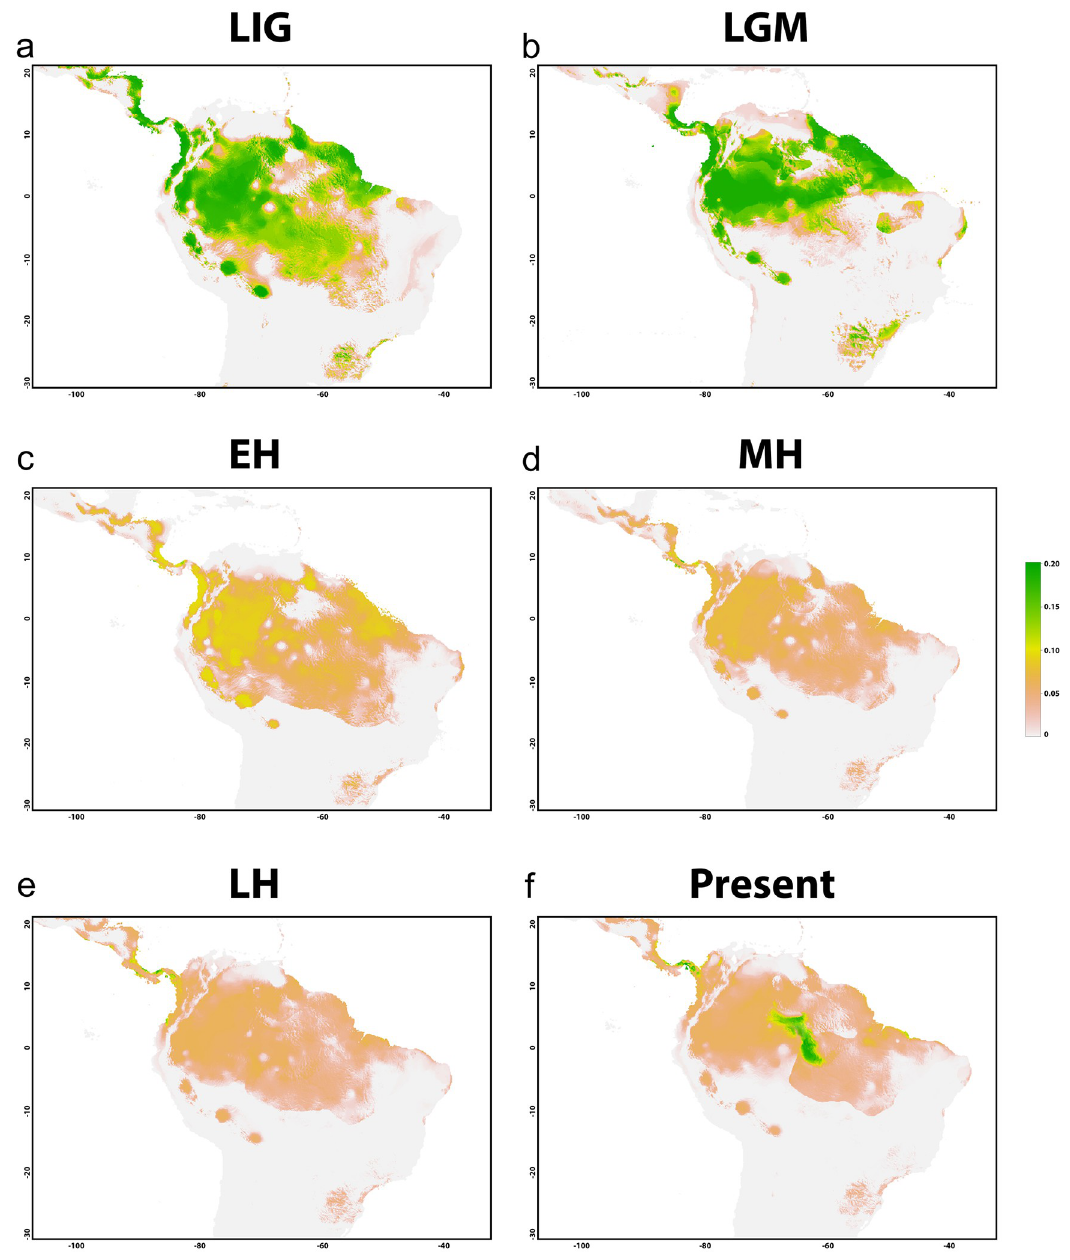
Fig 5. Paleogeographic modelling. Potential climatic niche for P . wallacei recovered in our analyses. (a) Last Interglacial (LIG), (b) Last Glacial Maximum (LGM), (c) Early Holocene (EH), (d) Middle Holocene (MH), (e) Late Holocene (LH) and Present (f). Intense green indicates areas that are more susceptible to the occurrence of the species and yellow tones indicate areas that are less susceptible for P . wallacei . The data were download from PaleoClim (paleoclim.org) and the resulting maps were displayed using the USDM packet in R (R Development Core Team 2017) (https://cran.rproject.org/web/packages/usdm/index.html). pairs and in only one acrocentric chromosome (pattern shared between both cytotypes). In addition, while in the marine species the 18S rDNA was found in centromeric and terminal positions (in some cases in both chromosome arms) [44, 46] in freshwater stingrays the sites are only found on the terminal position of long arm [28, present study]. This variations could